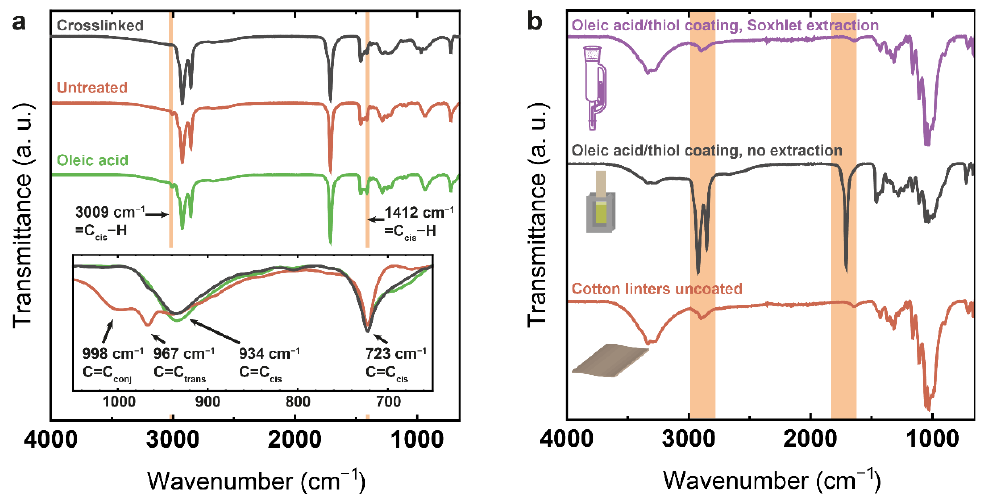
Figure 3. ( a ) FTIR spectra of pure oleic acid, the untreated oleic acid/thiol mixture and the crosslinked coating highlighting the transformations characterized by double bond conversion; ( b ) FTIR spectra of uncoated cotton linters paper, cotton linters paper coated with crosslinked oleic acid/thiol mixture and the same after Soxhlet extraction show that the coating is not permanently linked to substrate.